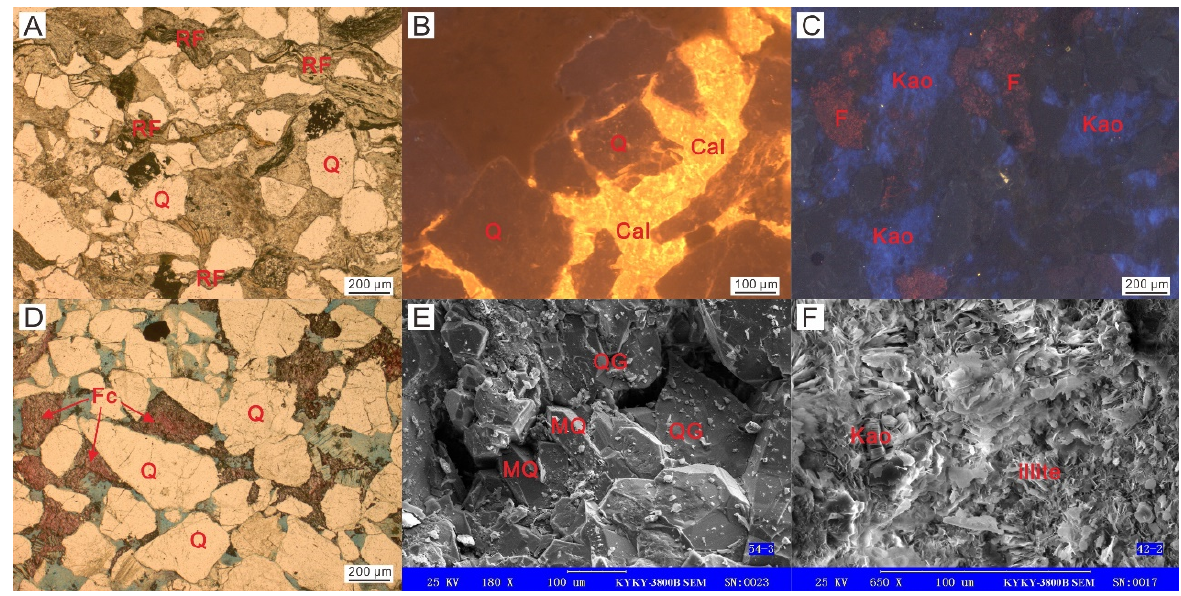
Figure 11. Photomicrographs recording the diagenesis of the Lower Shihezi reservoirs in the Hangjinqi area, north Ordos Basin. ( A ) Pseudoplastic deformation of soft rock fragments, well J103, 2696.86 m, plane-polarized light; ( B ) Calcite cements filling in the large pores with poikilitic tex- ture, well J103, 3081.33 m, CL; ( C ) Feldspar dissolution and pore-filling kaolinite, well J103, 2987.21 m, CL; ( D ) Ferrocalcite cements filling in the relatively small pores, well J62, 3455.94 m, CL; ( E ) Quartz overgrowth and micro quartz, well J89, 3164.48 m, SEM. ( F ) Illite and kaolinite filling in the pores, well J92, 3066.1 m, SEM. Q = Quartz; RF = Rock fragments; Cal = Calcite; F = Feldspar; Kao = Kaolinite; Fc = Ferrocalcite; QG = Quartz overgrowth; MQ = Micro